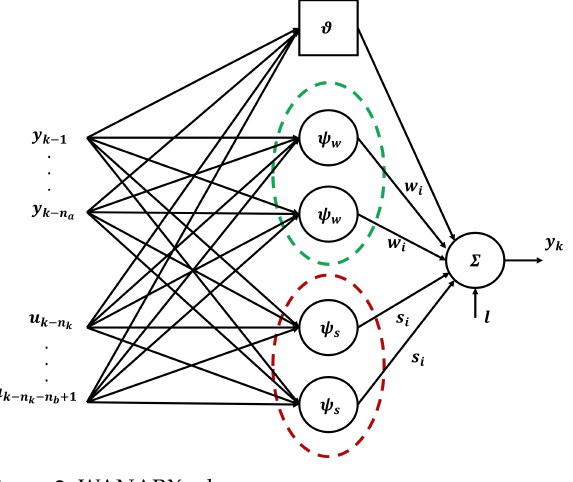
Figure 2. WANARX